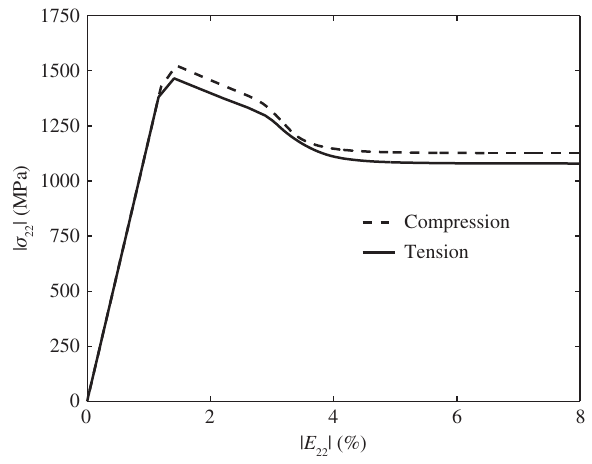
Figure 12 Sample S stress component | σ compressive loading.